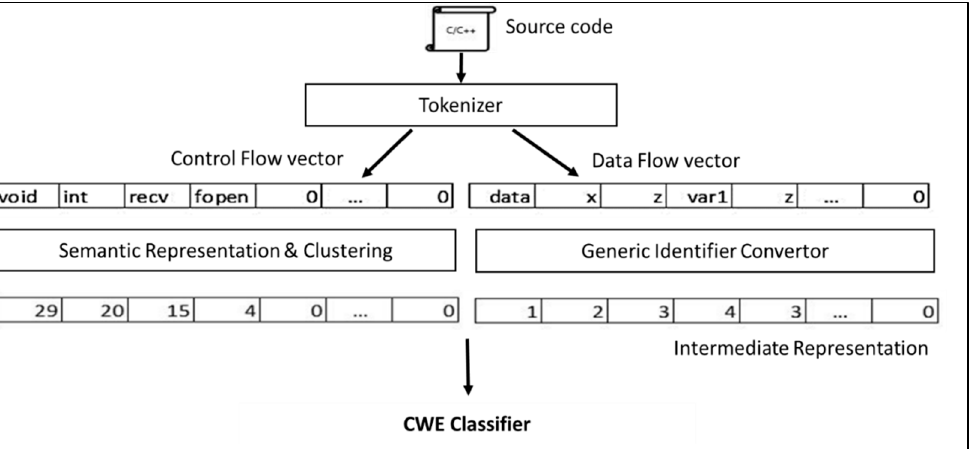
Figure 1. Architecture of the proposed multi-language CWE scanner using Intermediate Represen-